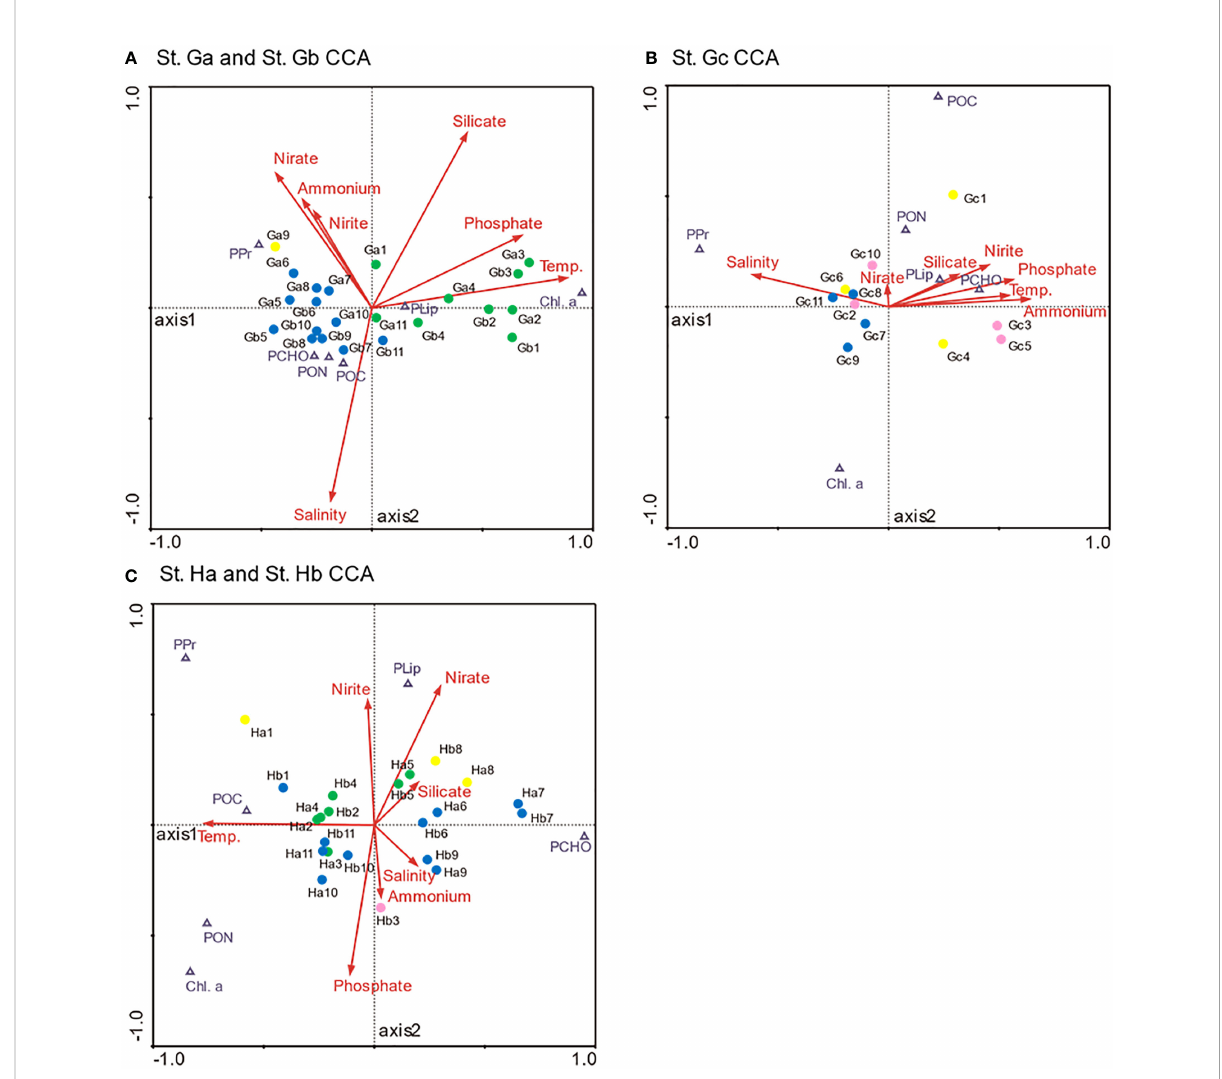
FIGURE 7 Ordination diagram obtained from canonical correspondence analysis based on Chl- a , POC, PON, PCHO, PPr, and PLip located in St. Ga and Gb (A) , St. Gc (B) , and St. Ha and St. Hb (C) with respect to environmental